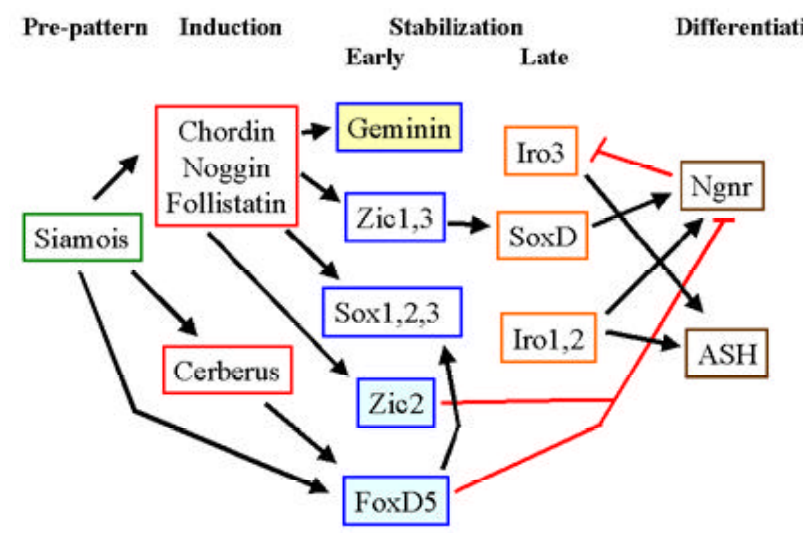
FIGURE 3. Many genes are involved in the neural fate stabilization pathway. Arrows indicate experimental evidence (reviewed in text) that the upstream gene activates the expression of the downstream gene. Red bars indicate experimental evidence that one gene inhibits the expression of another. Arrows and bars are missing at many levels because the data are yet to be reported. All neural fate stabilization genes (blue and orange boxes) are downstream of neural inducers (boxed in red). However, FoxD5 is not downstream of Chordin or Noggin, but is induced by the Siamois/Cerberus pathway. All neural fate stabilization genes are upstream of early expressed proneural genes (boxed in brown) and the later differentiation pathway. Those neural fate stabilization genes that are expressed earliest in the neural plate are boxed in blue, and those that are expressed later are boxed in orange. The early neural-fate stabilizing genes either enhance differentiation (white shading), inhibit differentiation (blue shading), or promote proliferation (yellow shading). The late neural-fate stabilizing genes are thought to be just upstream of early proneural genes. There is a paucity of knowledge of how the many different neural fate-stabilizing genes regulate each other and their downstream